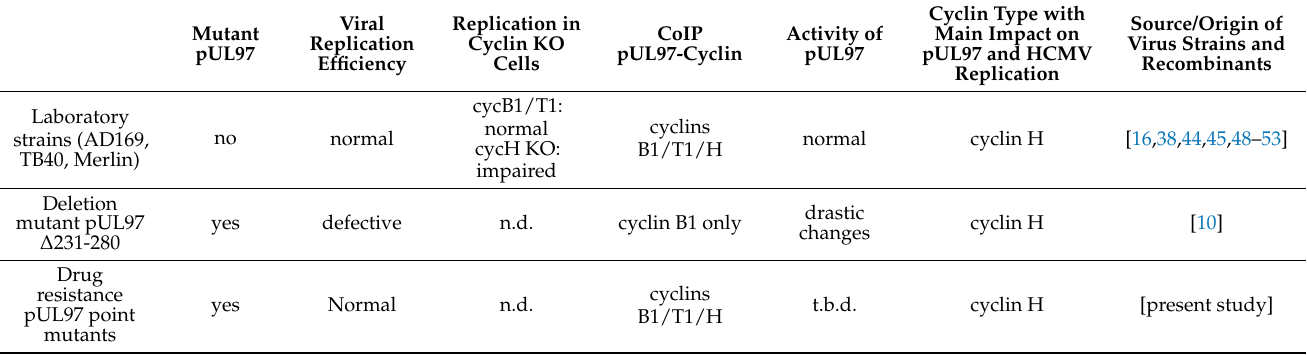
Table 2. Viral characteristics relating to pUL97-cyclin